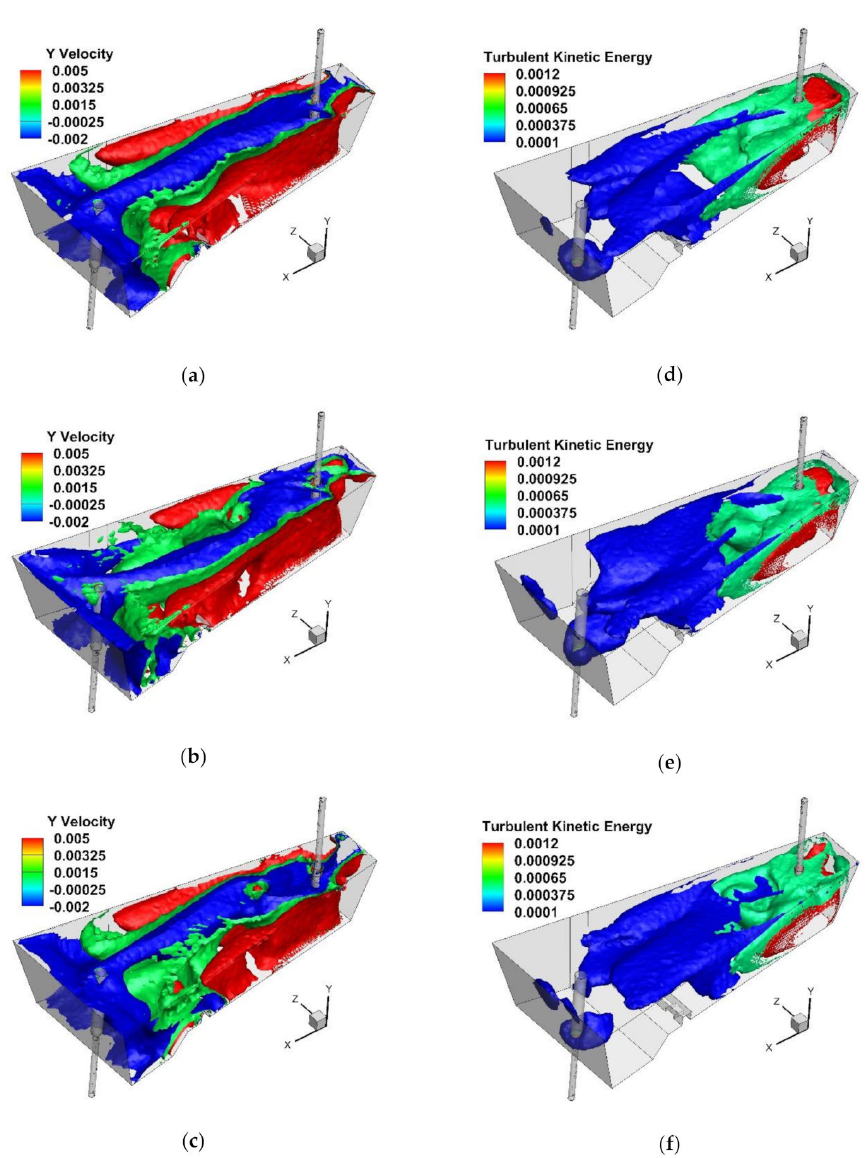
Figure 10. Y component velocity (m/s) and turbulent kinetic energy (m 2 /s 2 ): ( a , d ) tundish with SFC No. 2C105, ( b , e ) tundish with SFC No. 2C125, ( c , f ) tundish with SFC No.